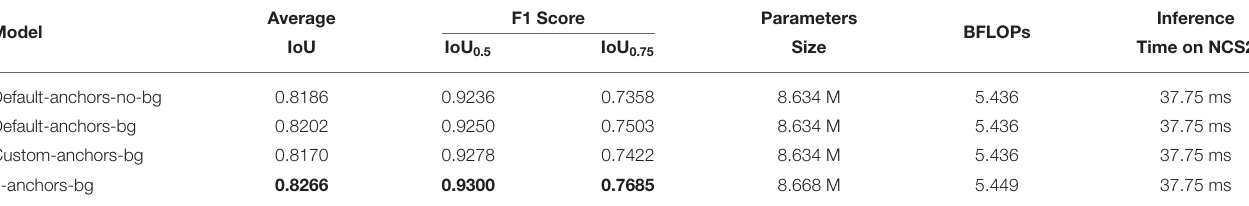
TABLE 2 | Accuracy incremental